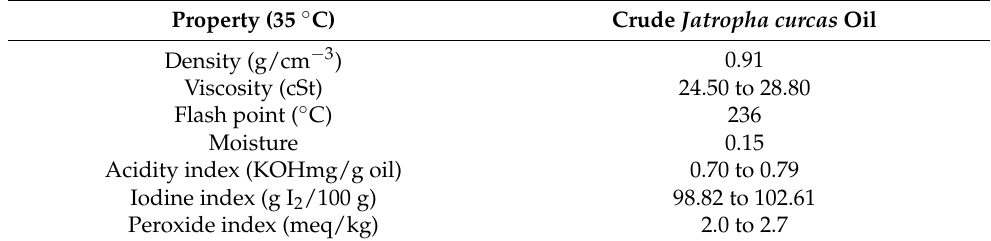
Table 3. Properties of crude Jatropha curcas L.